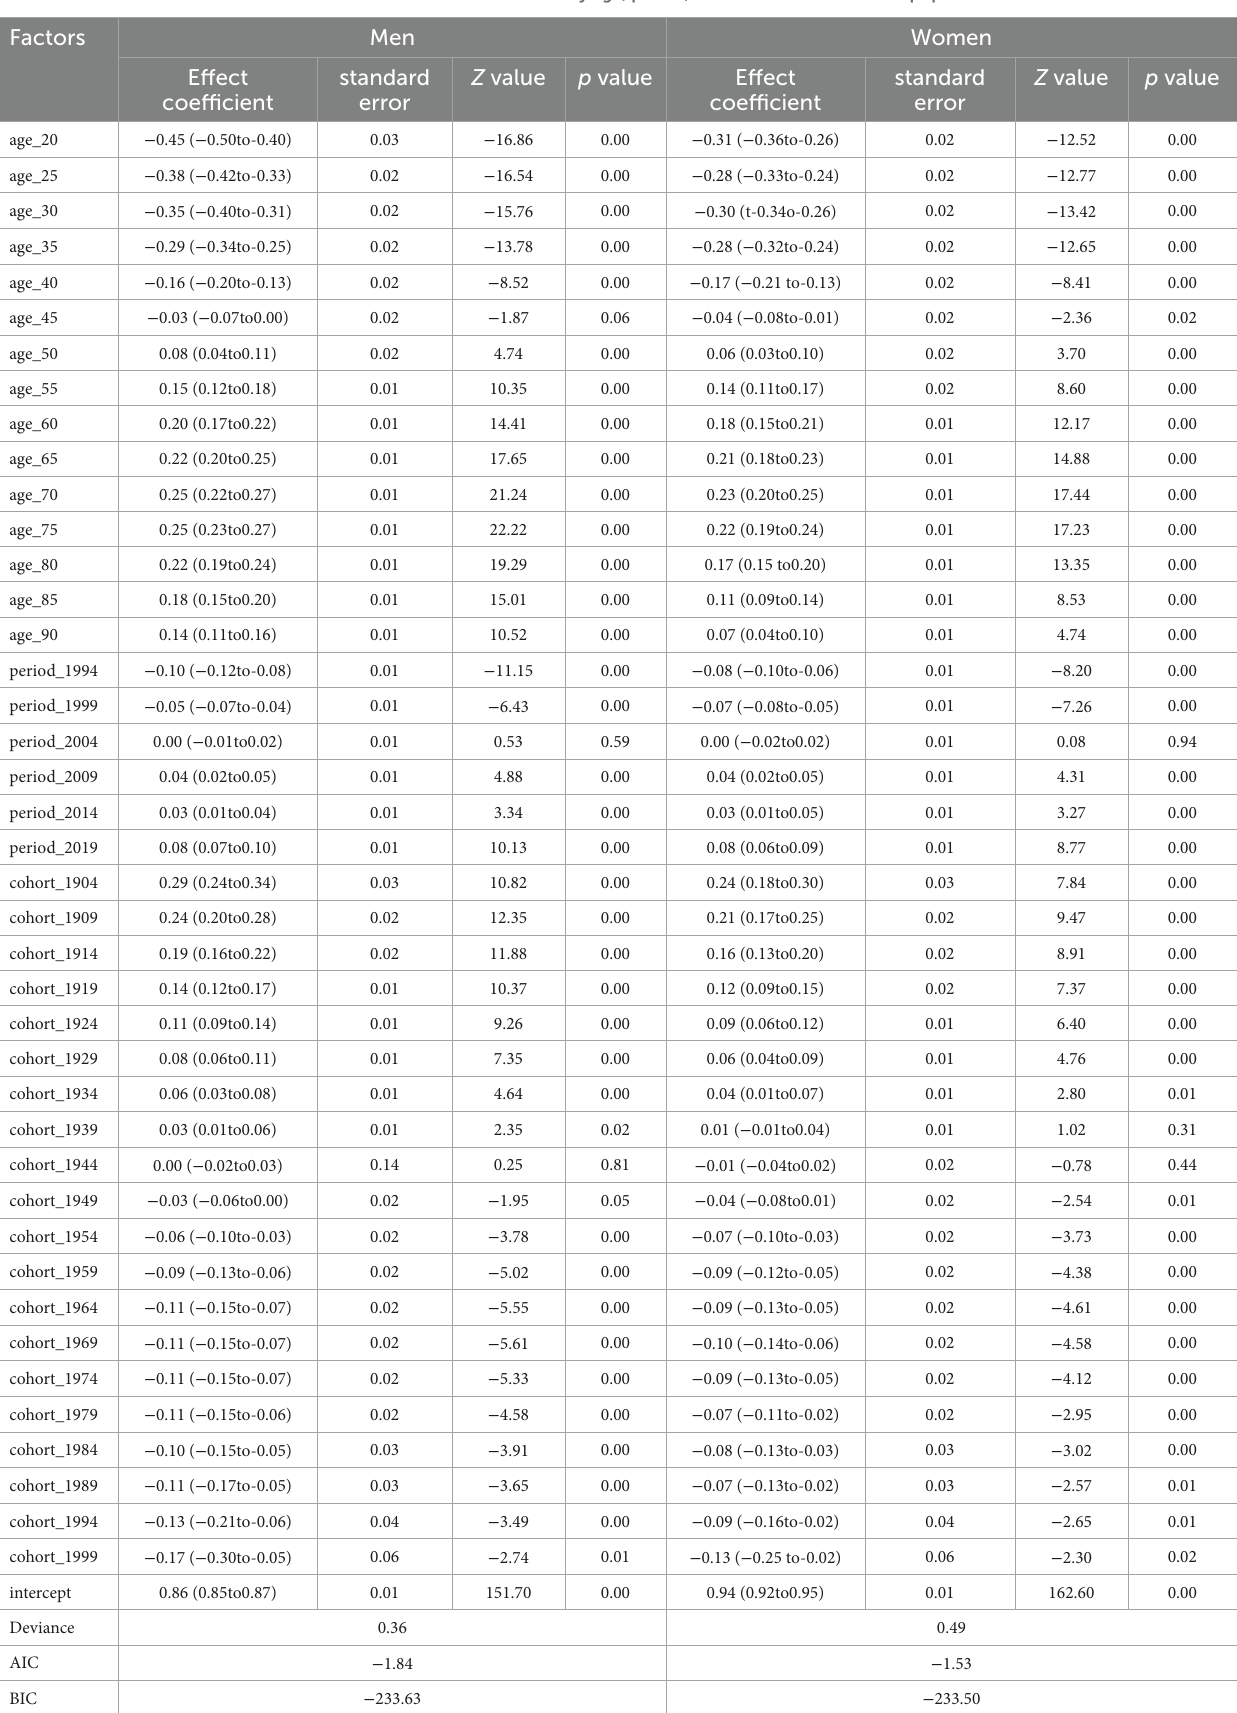
TABLE 2 Relative risk and 95% CI for the incidence of edentulousness by age, period, and cohort in the Chinese population. Factors Men Women Effect coefficient